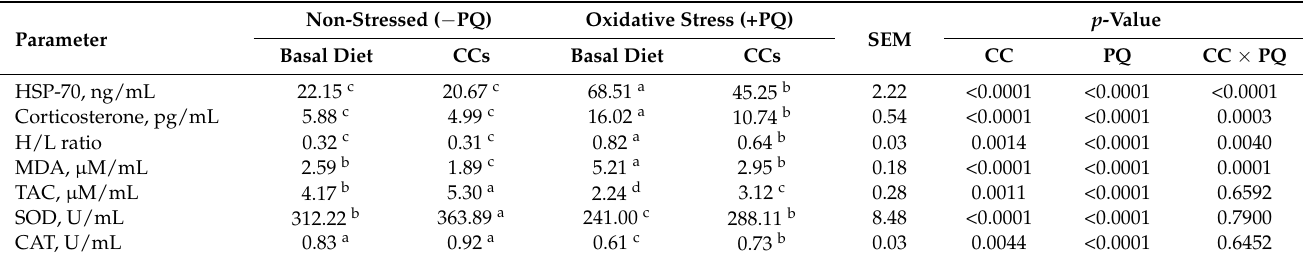
Table 5. Stress response of layers subjected to paraquat-induced oxidative stress (PQ) and dietary Citrullus colocynthis seed supplementation (CCs).